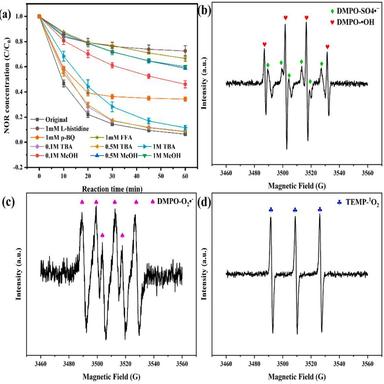
The effect of various quenchers on NOR degradation (a), the EPR test of SO4•− and •OH (b), the EPR test of O2•− (c) and 1 O2 (d).